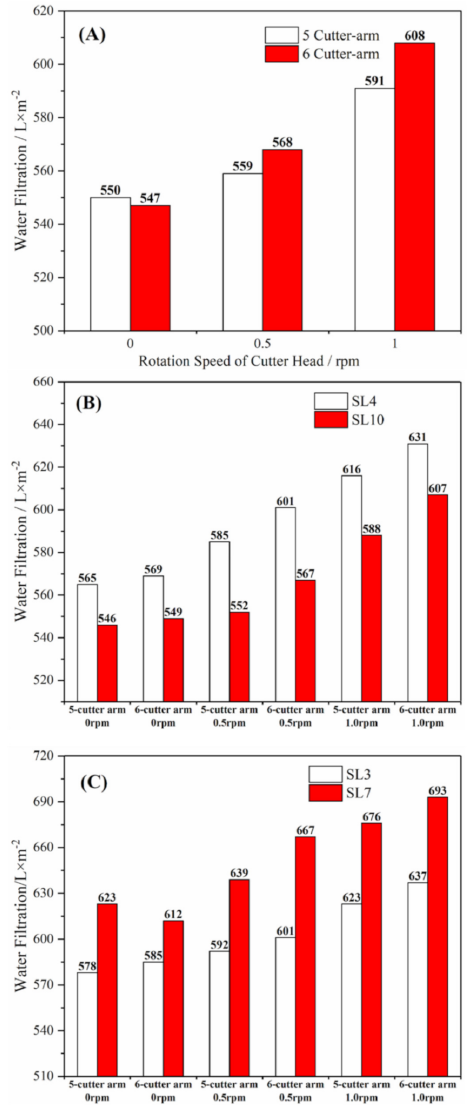
Figure 10. Influences of the cutter head and slurry parameters on water filtration. ( A ) is the final water filtration volume produced with different cutter heads and rotation speeds for the SL5 slurry sample. ( B ) is the final water filtration volume produced with different cutter heads and rotation speeds for the SL4 and SL5 slurry samples. ( C ) is the final water filtration volume produced with different cutter heads and rotation speeds for the SL3 and SL7 slurry